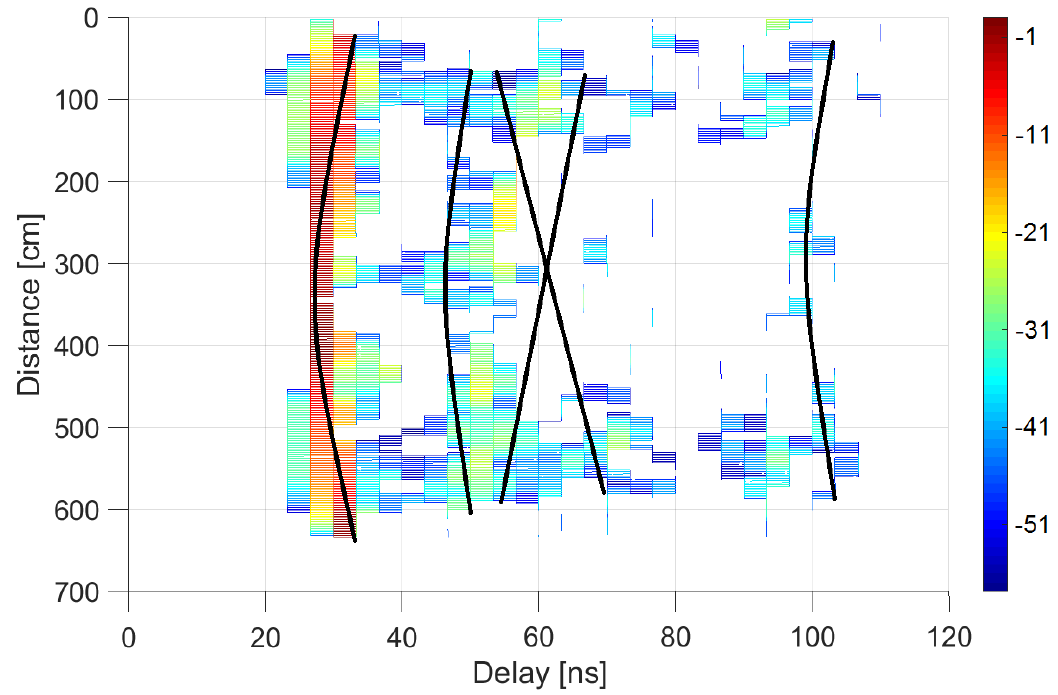
Figure 7. Power delay profile at auditorium with receiver moving in transverse direction: measurements (in dB relative to maximum) and ray-tracing analysis.